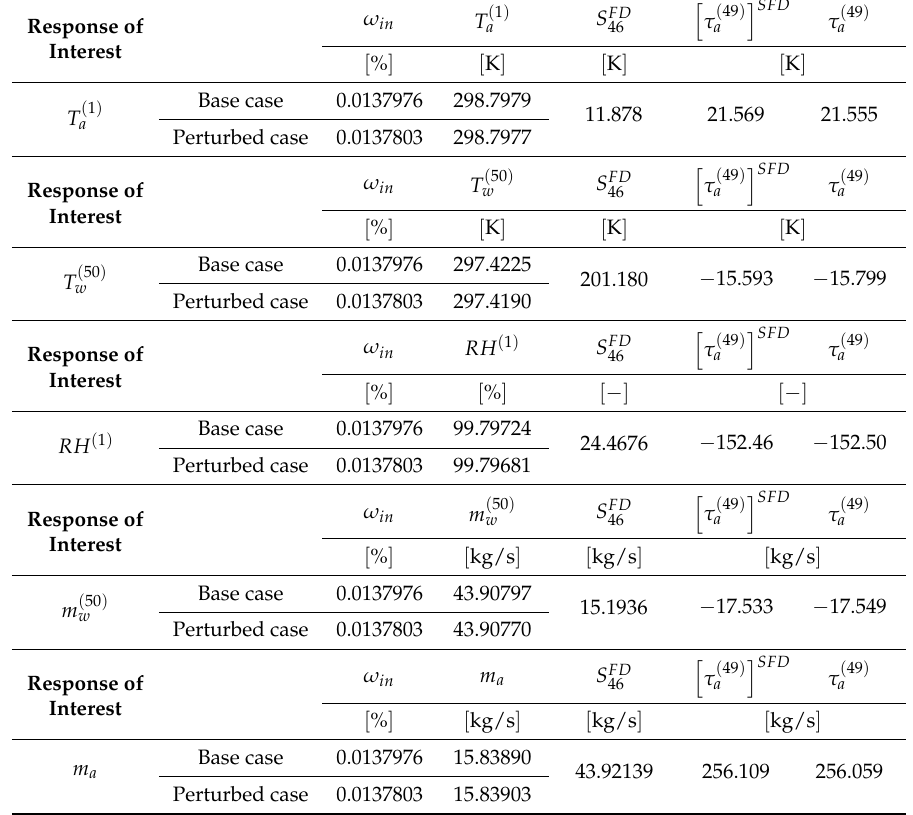
Table E3. Verification Table for adjoint function τ ( 50 ) m w and m a